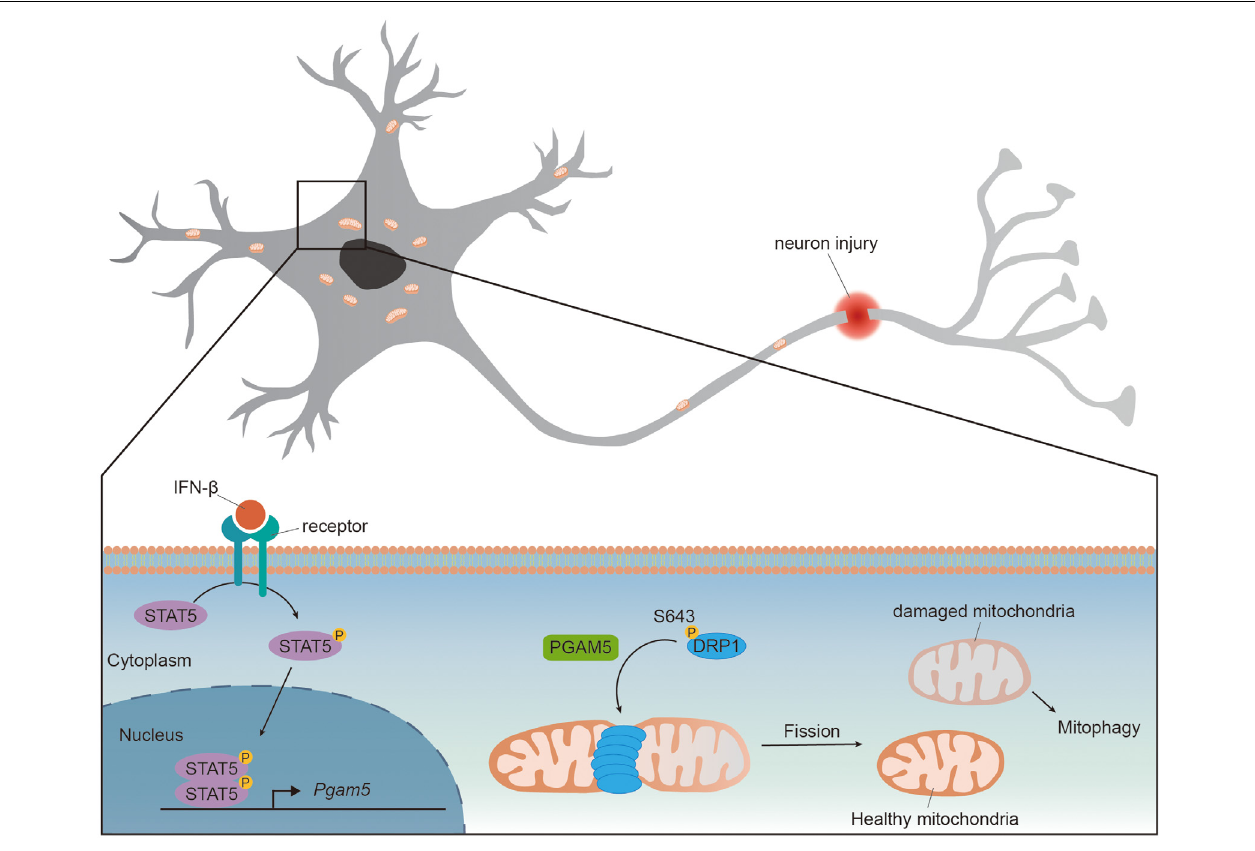
FIGURE 1 | PGAM5 dephosphorylates DRP1 to promote mitochondrial fission. The expression level of PGAM5 is upregulated in neurons upon injury or IFN- β treatment. IFN- β binds to IFNAR receptors and activates transcription factor STAT5. Activated STAT5 translocates to nucleus and enhances expression of Pgam5 . The upregulated PGAM5 dephosphorylates Ser643 of DRP1 and recruits DRP1 to mitochondria, promoting mitochondrial fission and the elimination of damaged part of